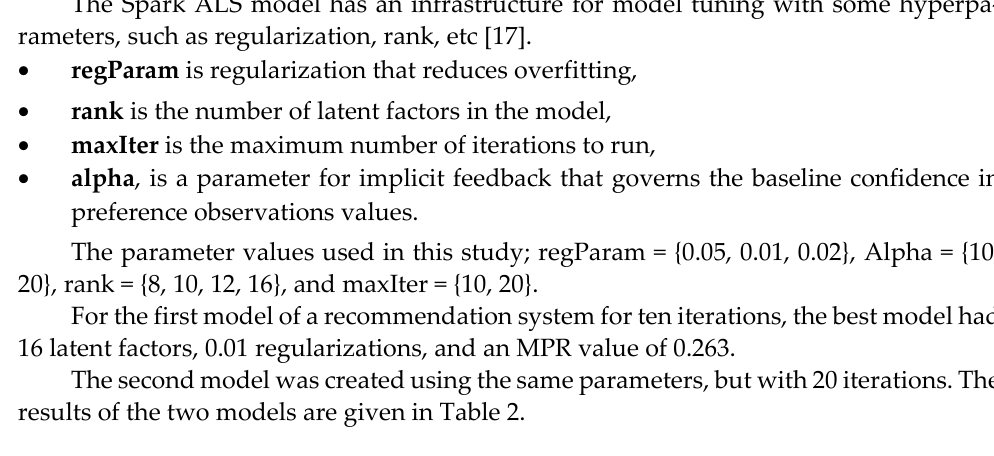
Table 2. Results of